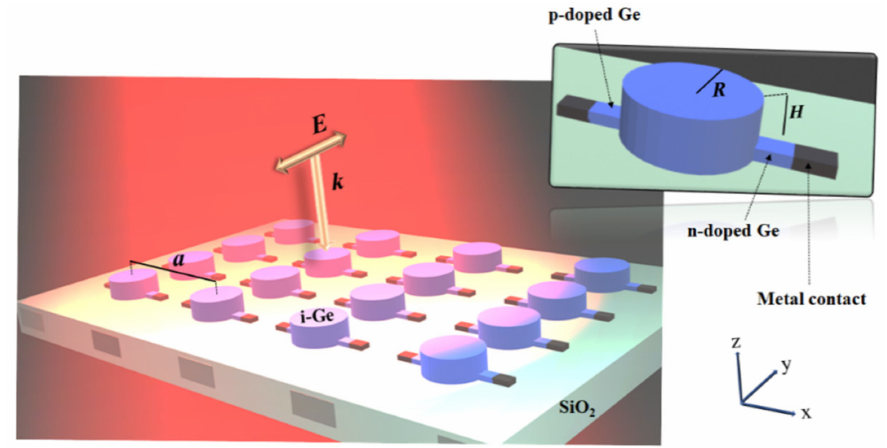
Figure 1. An array of PIN structures under the surface illumination of a y-polarized plane wave. Each pixel (see inset on the right) consists of a germanium (Ge) nanodisk of a radius R and a height H, sandwiched between two n- and p-doped Ge layers while metal contact circuits are embedded in the silicon dioxide